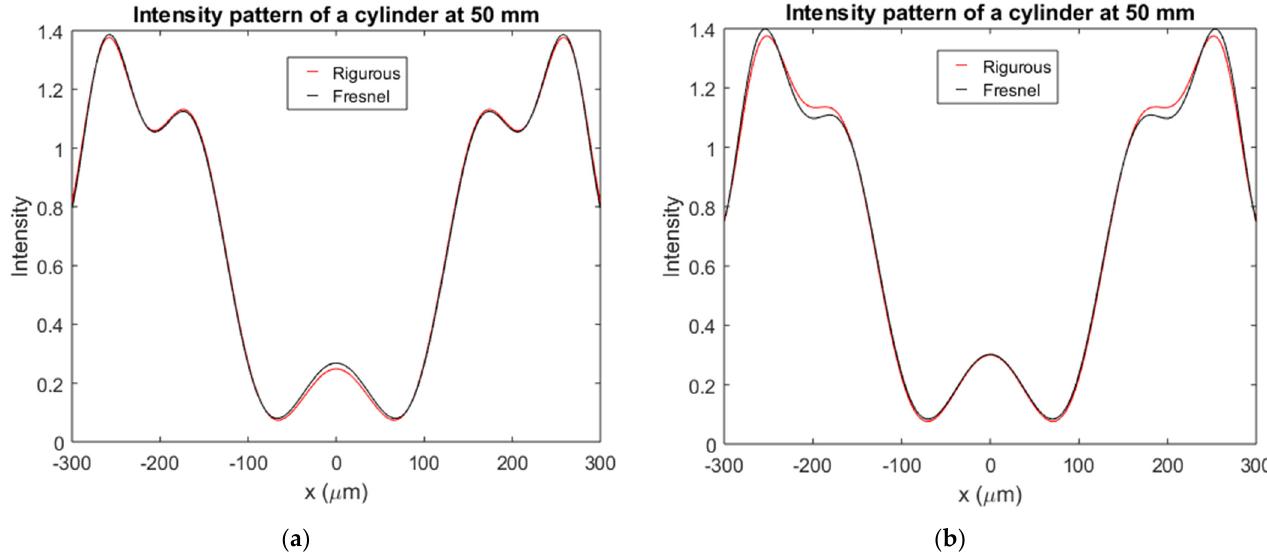
Figure 8. Intensity of the diffraction pattern as function of the distance to the center of the diffraction pattern for a dielectric cylinder with internal radius a = 80 µm: ( a ) with refractive index n = 1.85; ( b ) with refractive index n = 3.4. The intensities were calculated assuming that the diffraction pattern was measured at an axial distance z = 50 mm from the fiber.